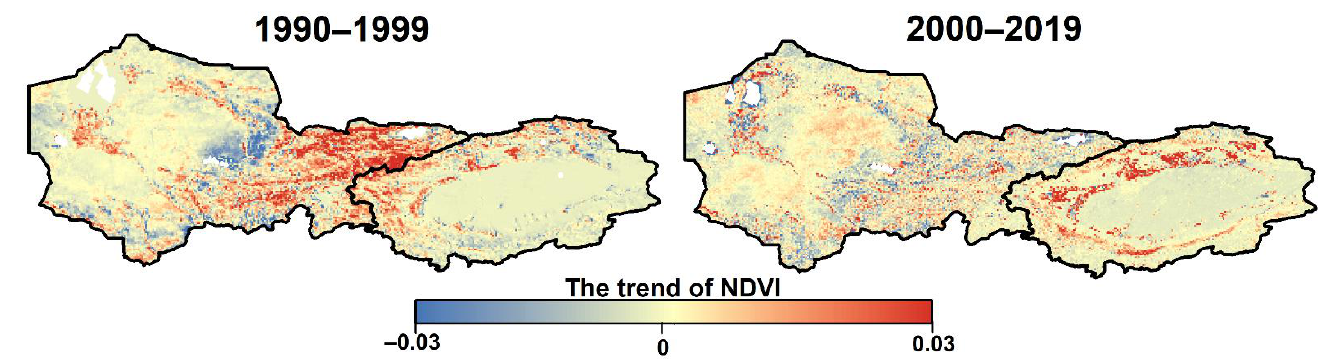
Figure 5. Spatial variation in the NDVI in the Aral Sea Basin and the Tarim River Basin, Central Asia, before and after EWC.